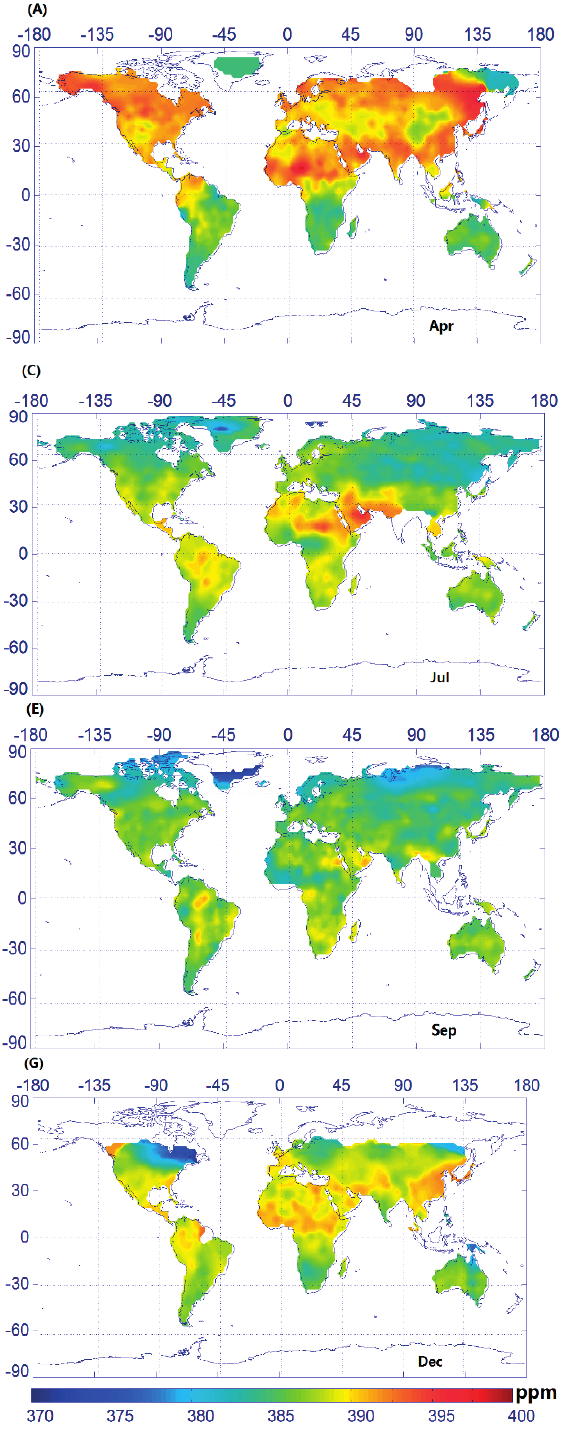
Figure 5. Monthly mean maps of the predicted fused data with associated standard deviation (gridded in 2° × 2° bins): ( A ) Predicted fused data for April 2010; ( B ) Associated standard deviation for the predicted value (April 2010); ( C ) Predicted fused data for July 2010; ( D ) Associated standard deviation for the predicted value (July 2010); ( E ) Predicted fused data for September 2010; ( F ) Associated standard deviation for the predicted value (September 2010); ( G ) Predicted fused data for December 2010; and ( H ) Associated standard deviation for the predicted value (December